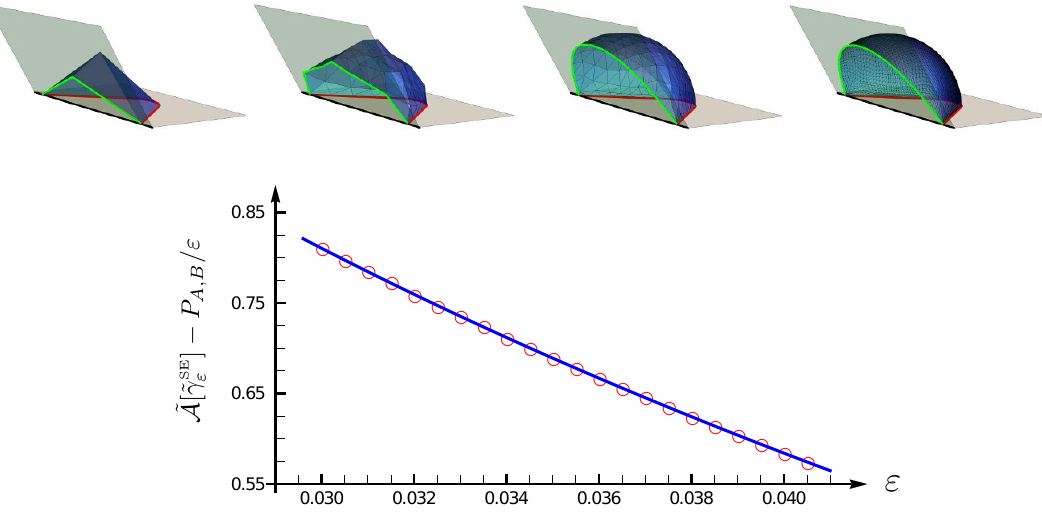
Figure 21 . An example of the numerical analysis of the corner functions based on Surface Evolver. Top: some stages of an evolution towards the minimal area surface anchored to the entangling curve given by the red line in the z = 0 half plane, which has (cid:13) = (cid:25)= 4 and L = 2 : 5 (see also (cid:12)gure 13). Here (cid:11) = (cid:25)= 3. Bottom: numerical data corresponding to the evolutions shown in the top panel for di(cid:11)erent values of " . Fitting this data as discussed in section A, one (cid:12)nds the numerical value